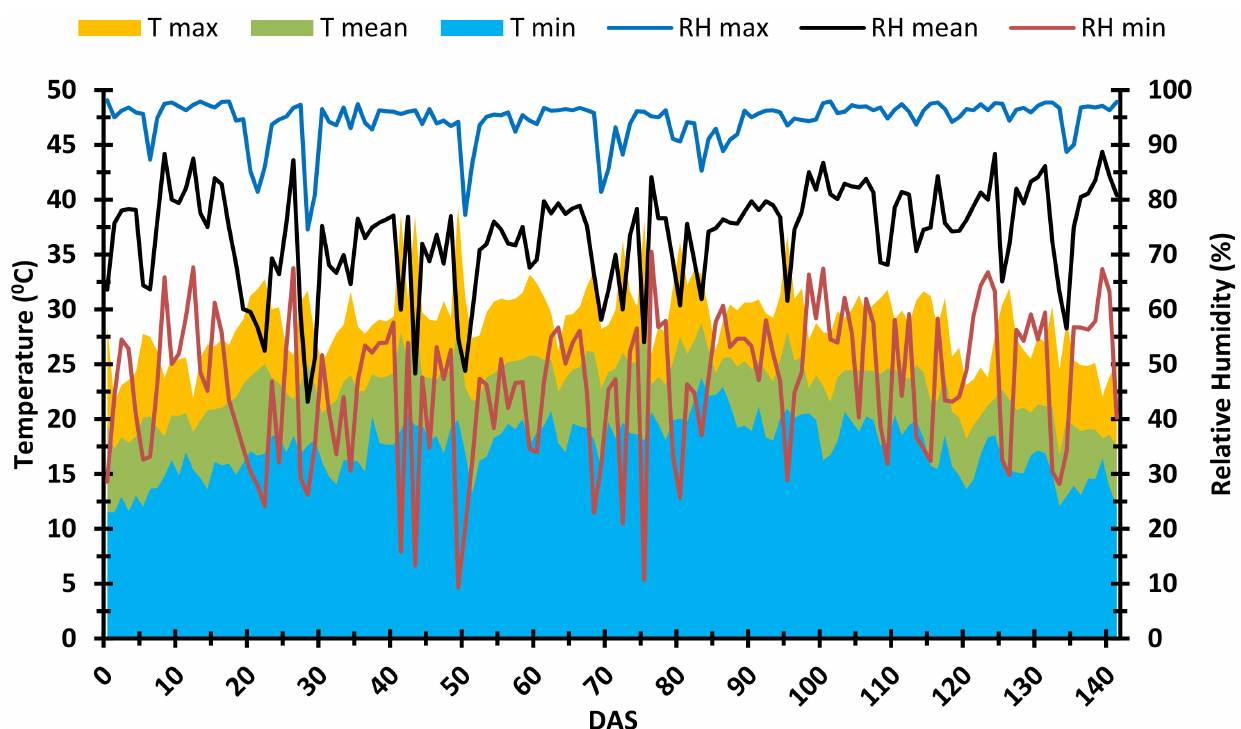
Figure 3. Maximum (T max), mean (T mean) and minimum (T min) temperatures; maximum (RH max), mean (RH mean) and minimum (RH min) relative humidity from sowing to harvest in the experimental plot area in